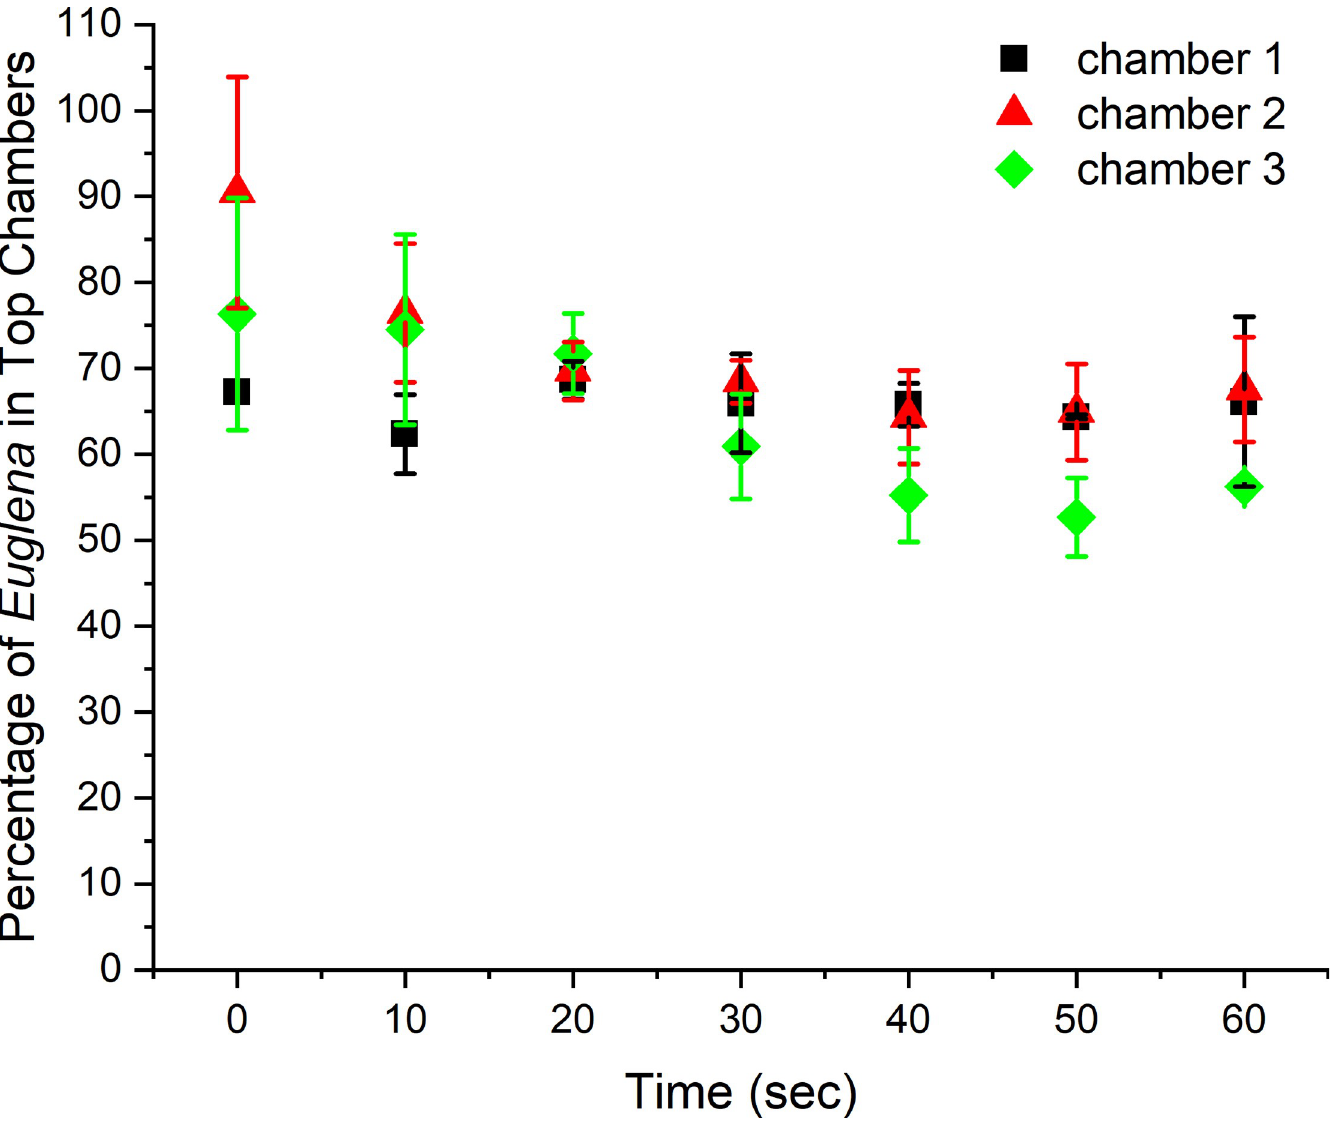
Fig 5. Euglena distribution (percentage of observed cells in top chambers over time) inside the microfluidic chambers without a chemoeffector. Uneven distribution of the illumination light from the microscope caused more cells to move to the top of the chambers.